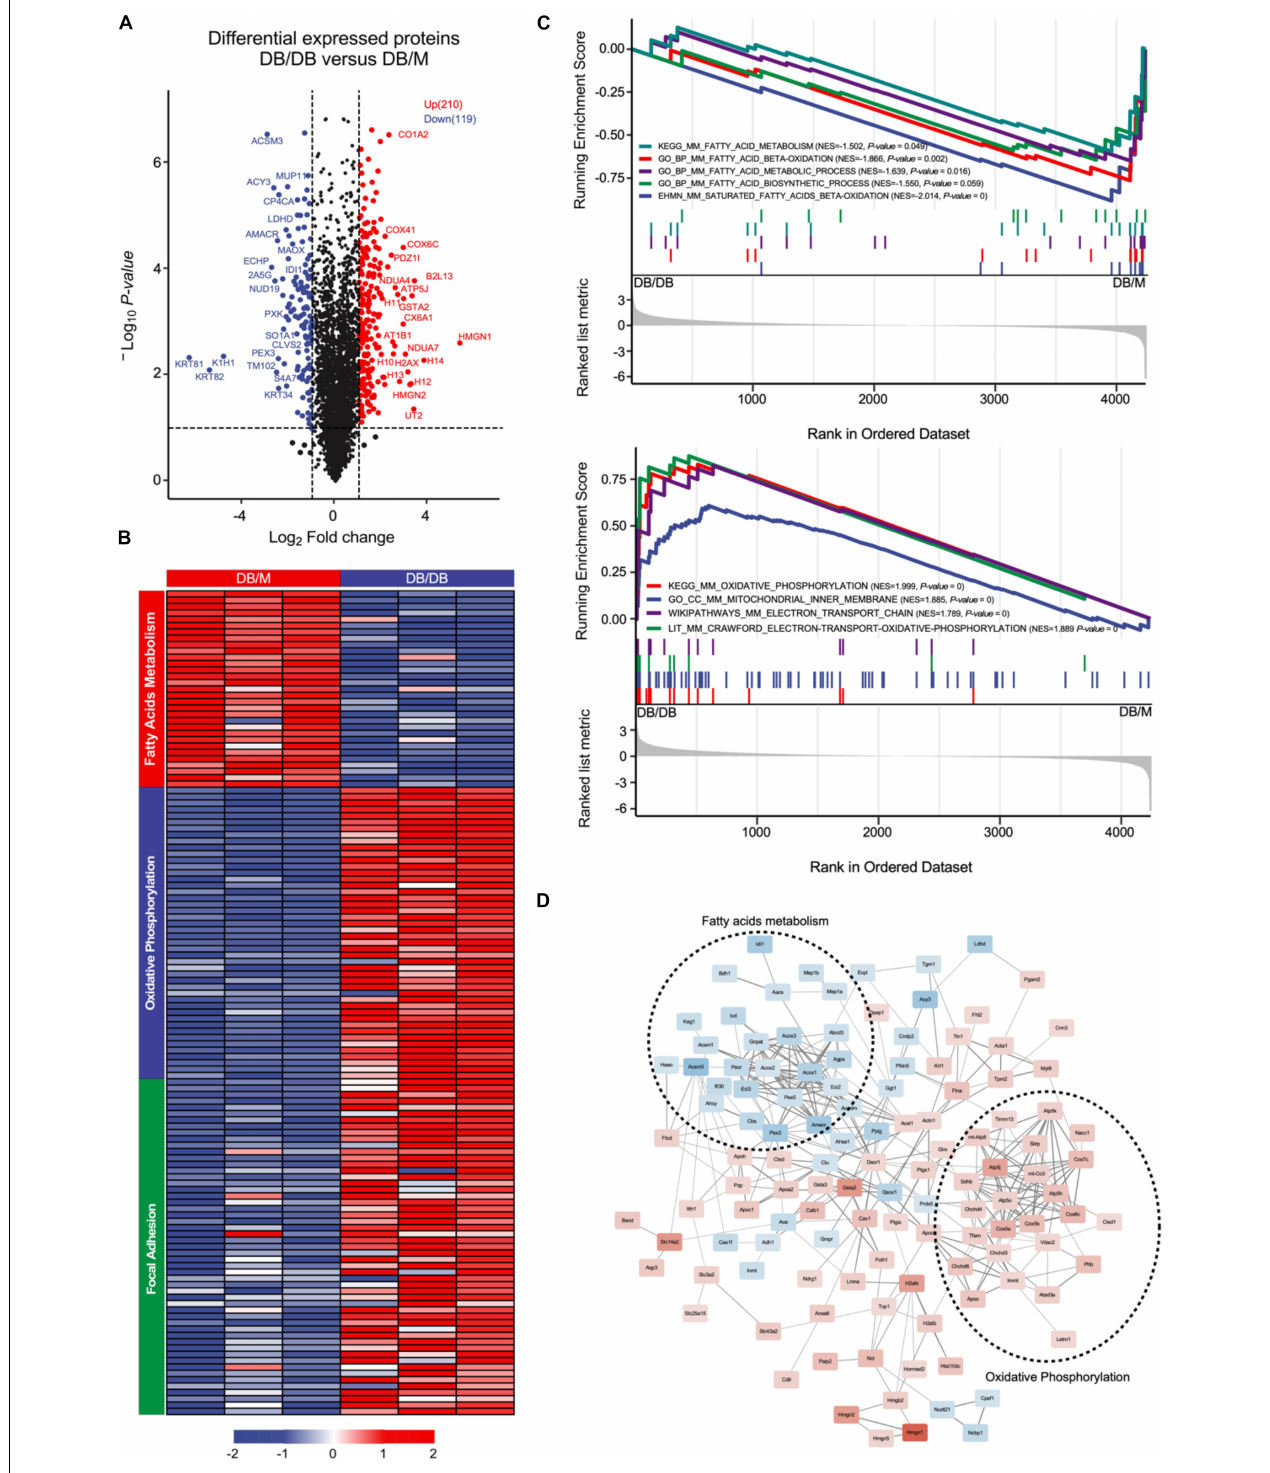
FIGURE 3 | Proteomics analysis between kidneys of db/db and db/m mice. (A) Volcano plot showing the DEPs between kidneys of db/db and db/m mice (18 weeks db/db, n = 3 kidney pools, 5 mice per pool; db/m, n = 3 pools, 5 mice per pool). (B) The heatmap illustrating the expression of DEPs in kidneys of db/db and db/m mice, each row represents one protein, each column represents one sample. (C) GSEA plot showing the different enriched pathways in db/db (down) or db/m (up) group. (D) DEPs network analysis based on string database, the thickness of line represents the strength of correlation, the size of rectangle represents the fold change between db/db and db/m group, and blue means downregulated and red means upregulated.